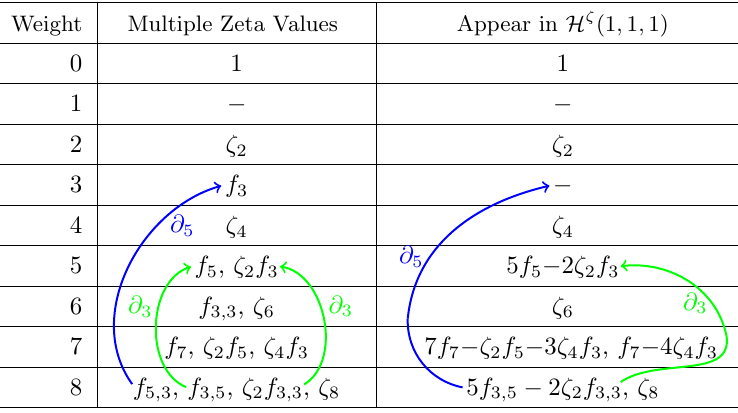
Table 3 . The left columns in table 2, rewritten in the f -alphabet. The arrows illustrate the action of the derivations @ 3 and @ 5